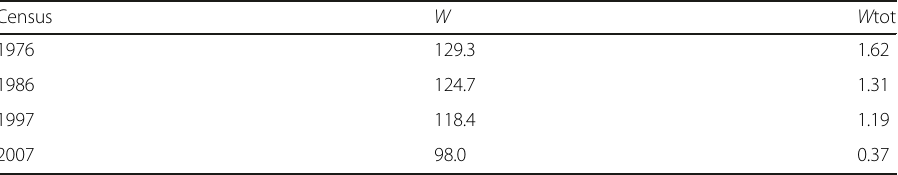
Table 1 Whipple ’ s index ( W ) for women aged 23 – 52, and total modified Whipple ’ s index ( W tot ) for women aged 21 – 52, Swaziland, 1976 – 2007 PHC